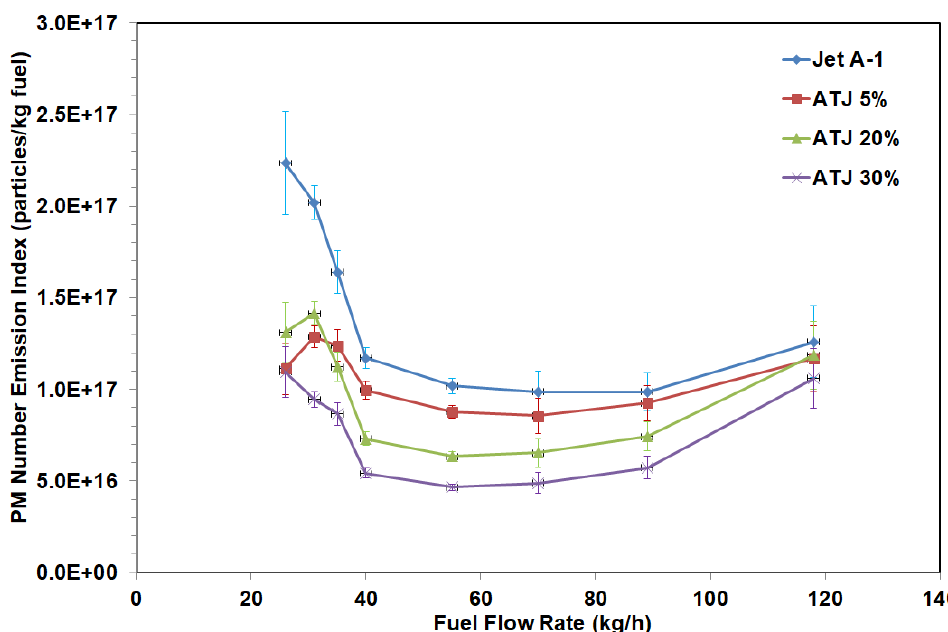
Figure 3. Particle number emissions index (EI N ) versus DGEN 380 fuel flow. Error bars represent single standard deviation.